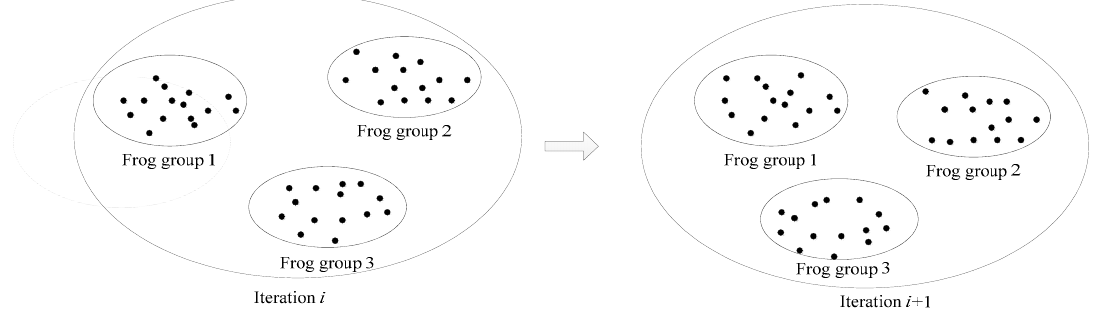
Figure 5. Multiple groups of frogs evolving in a solution space.